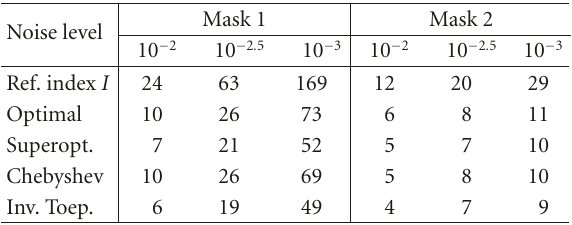
Table 4: Number of iterations for all the methods. Mask 3,